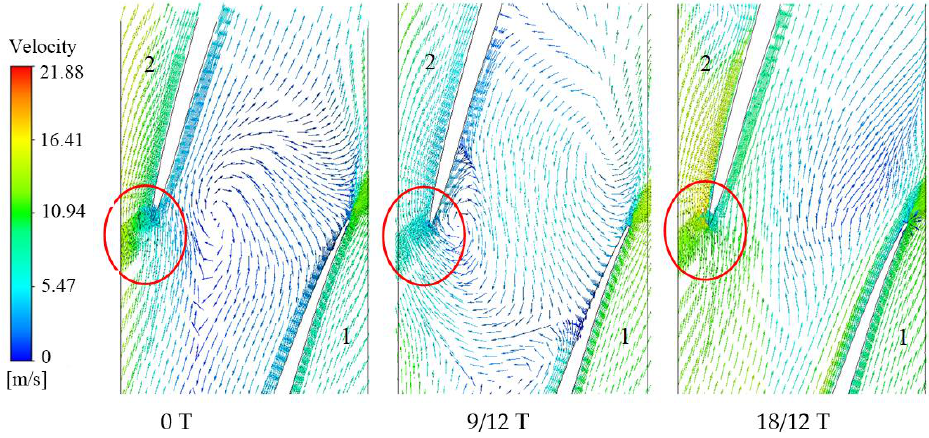
Figure 10. Velocity vector of impeller on the plane at 95% of span ( δ = 0.2 mm).